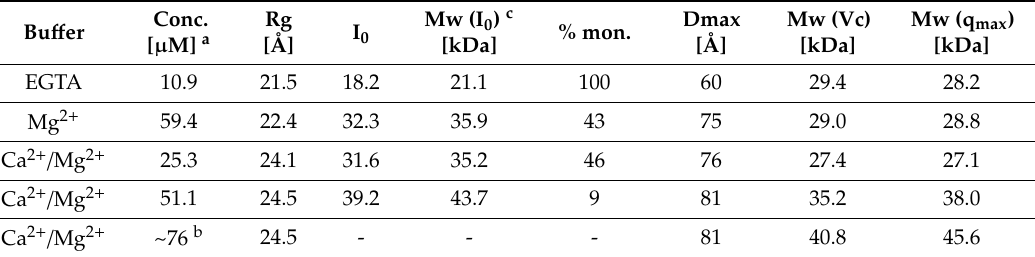
Table 1. SEC-SAXS parameters for hGCAP1 in di ff erent